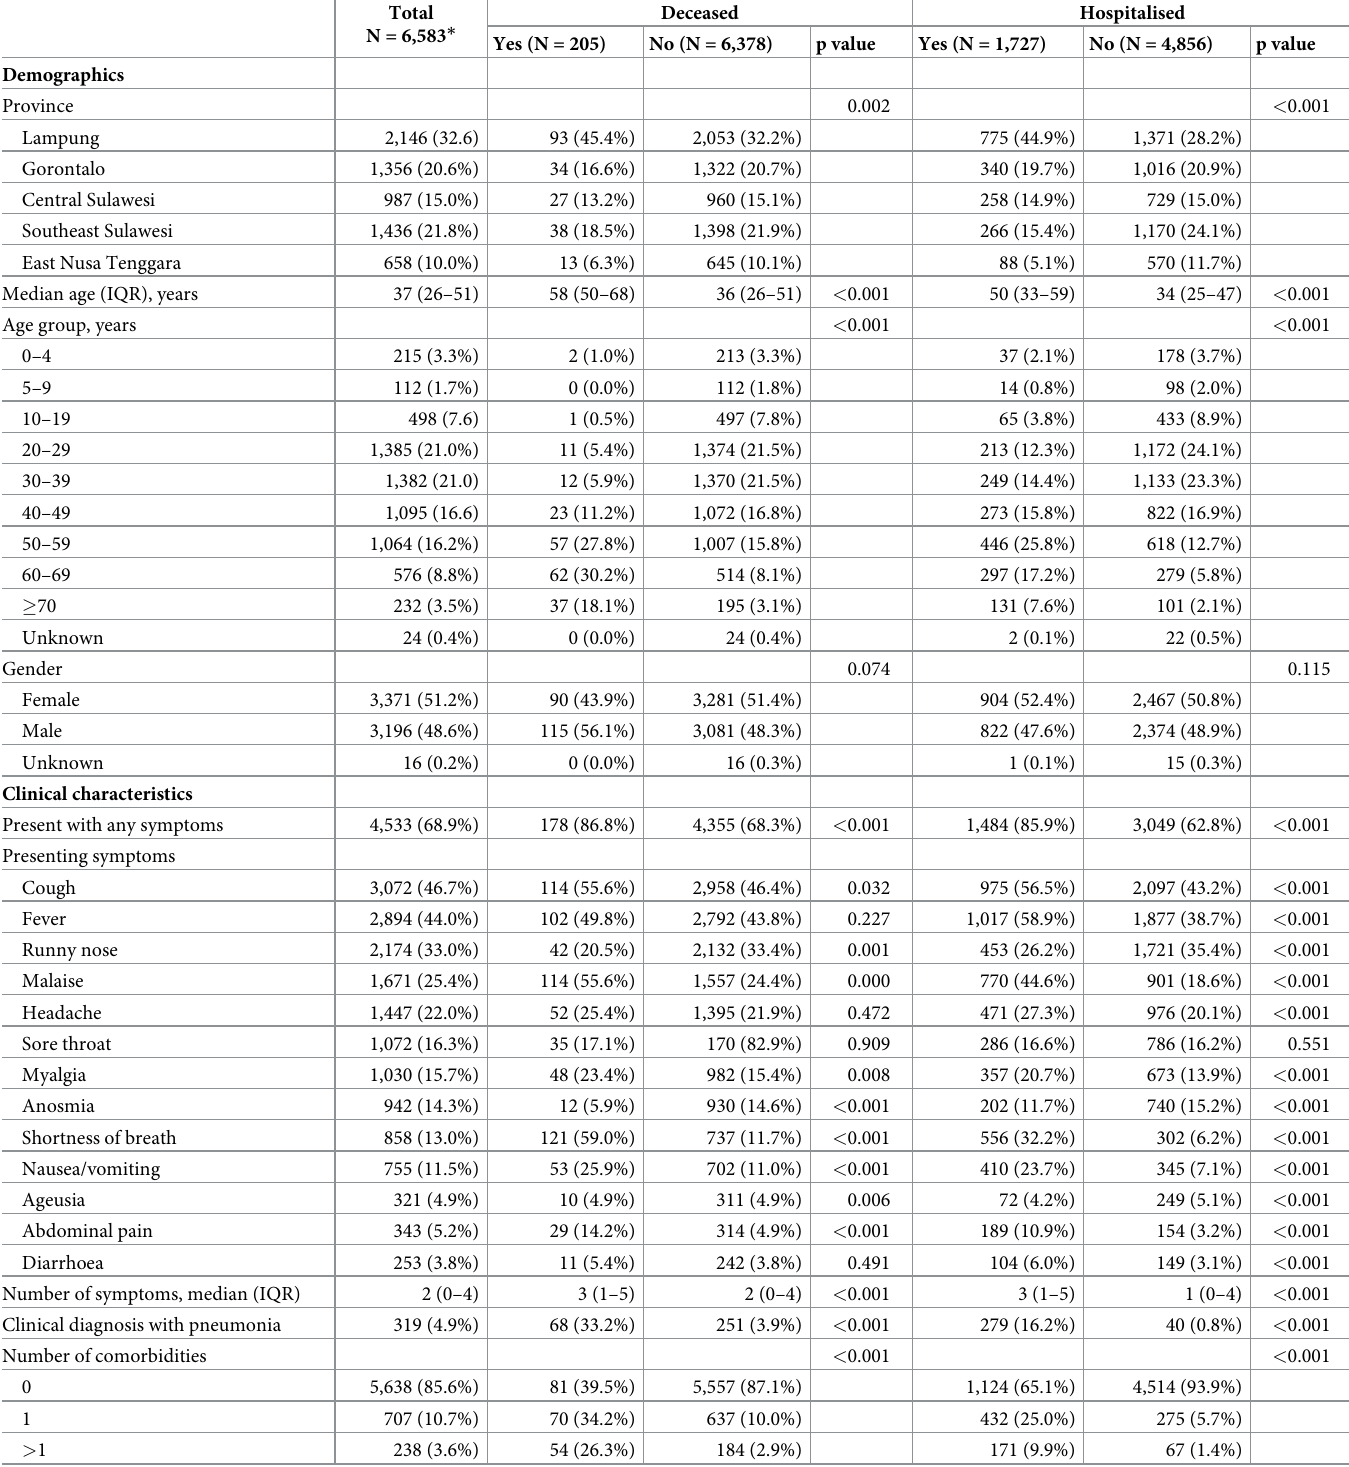
Table 1. Demographics, clinical characteristics, health care workers, and COVID-19-related mortality and hospitalisation in 5 rural provinces in Indonesia, 1 Janu- ary to 31 July